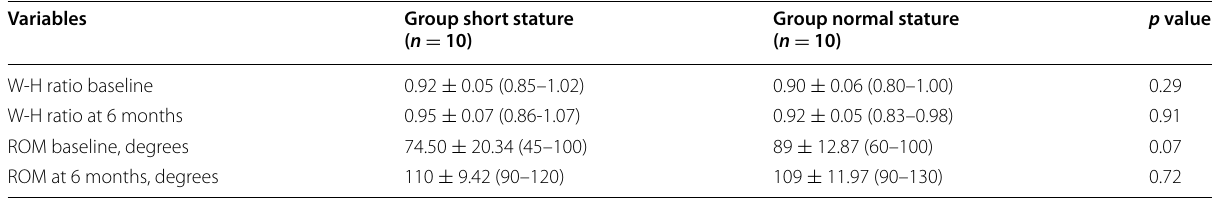
Data is represented as mean Table 2 Waist-hip (W-H) ratio and range of movement (ROM) in patients of short versus normal stature undergoing total knee